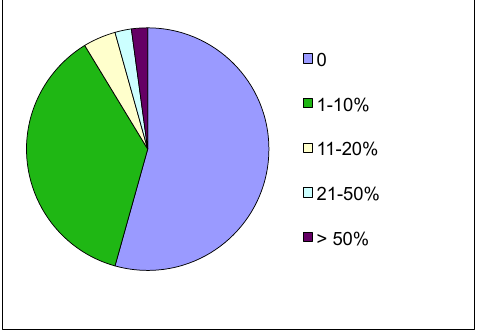
Figure 1. Percentage of students who study physical science while enrolled in one of 45 M. Div.